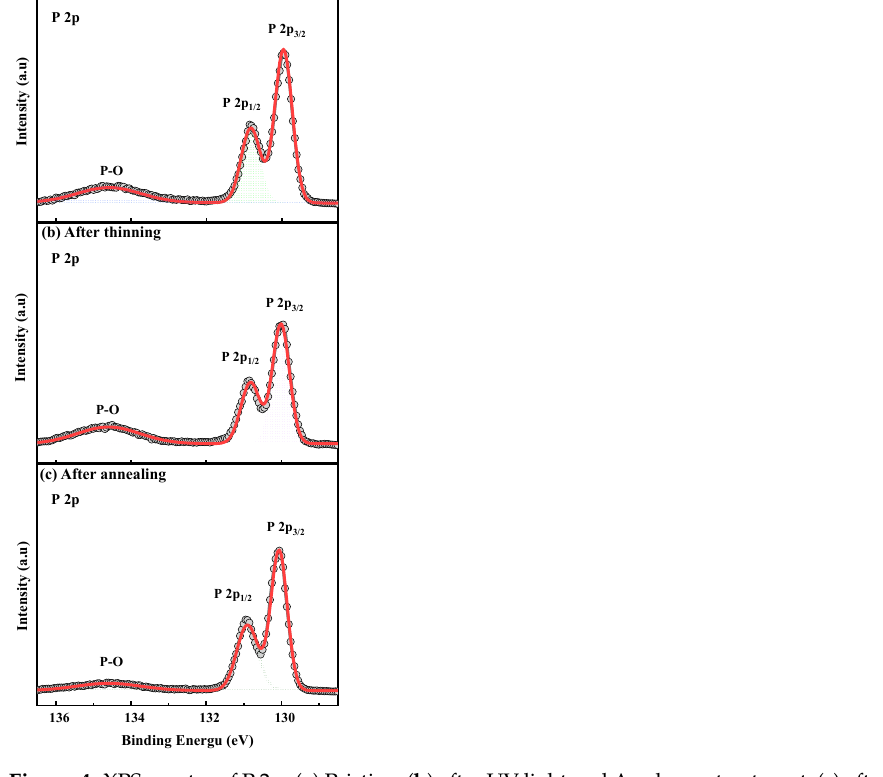
Figure 4. XPS spectra of P 2p. ( a ) Pristine; ( b ) after UV light and Ar plasma treatment; ( c ) after annealing.